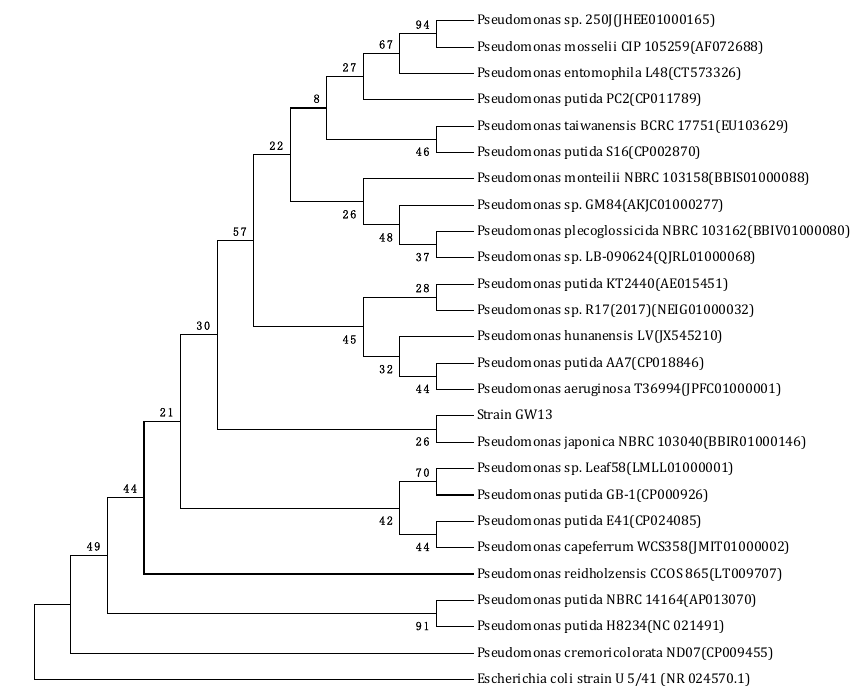
Figure 1. Phylogenetic tree derived from the 16S rRNA gene sequence of strain GW13 and sequences of related species in EzBioCloud by the neighbor joining method. Bootstrap values (%) are indicated at the